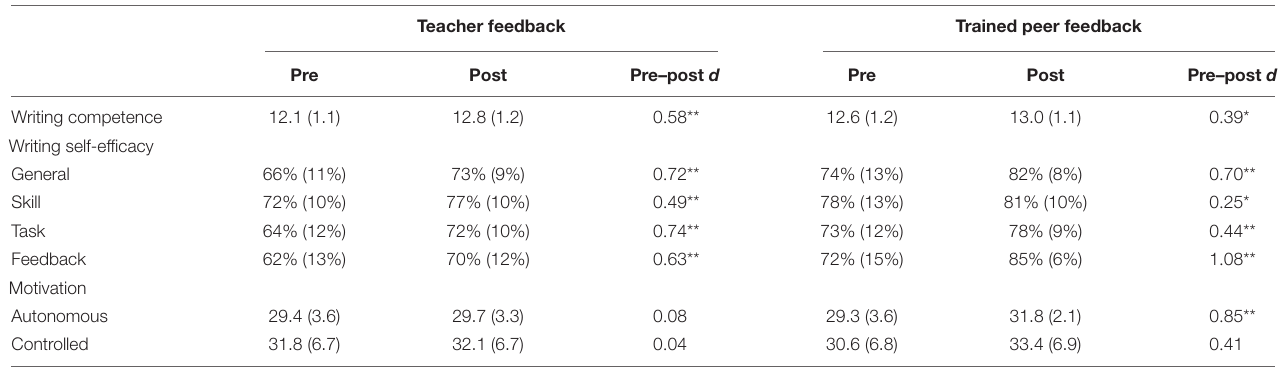
TABLE 4 | Mean (and SD) pre/post values and Cohen’s d of the pre–post growth in each condition for writing competence, writing self-efficacy, and self-regulated motivations.